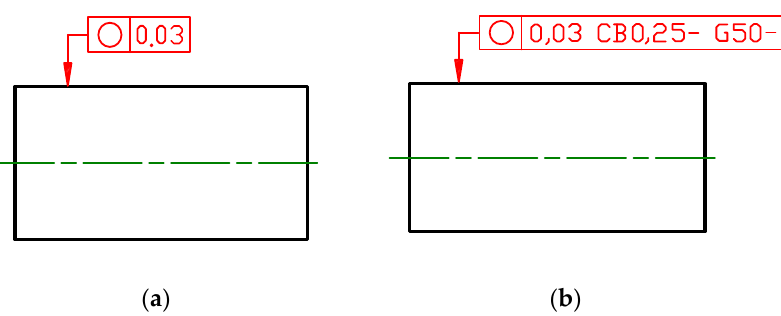
Figure 6. ( a ) Roundness tolerance—the default measuring conditions apply (ASME Y14.5); ( b ) roundness tolerance—to indicate the same measuring parameters in the ISO GPS system, measuring conditions should be directly specified.